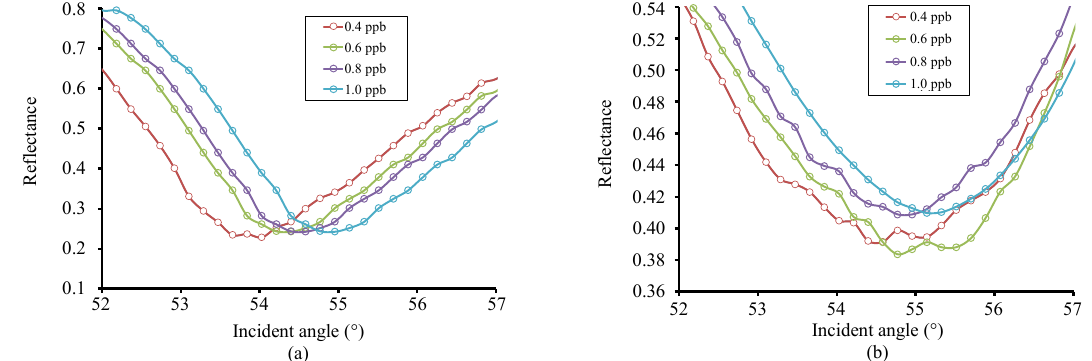
Fig. 6 Response curves of Fe 2 H 2 O 4 -SPR sensor when evaluated with (a) As(III) and (b) As(V) ion solutions within the concentration range of 0.4 ppb–1